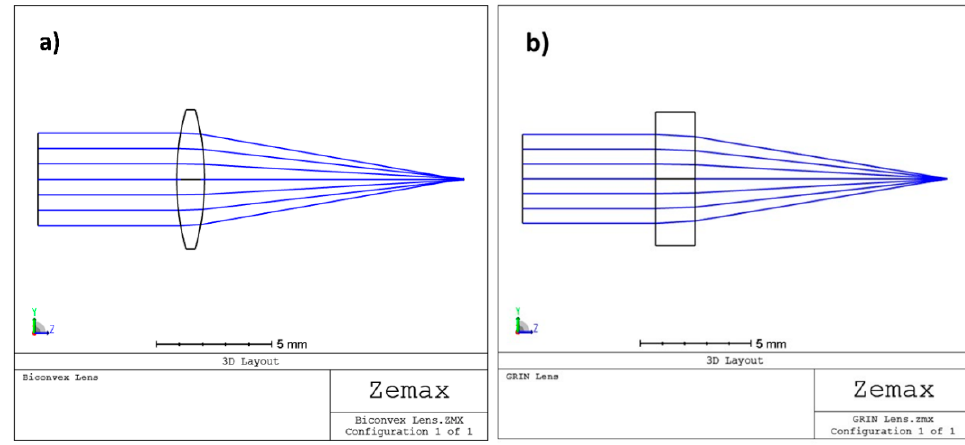
Figure 7. Layouts for ( a ) biconvex lens; ( b ) GRIN lens.